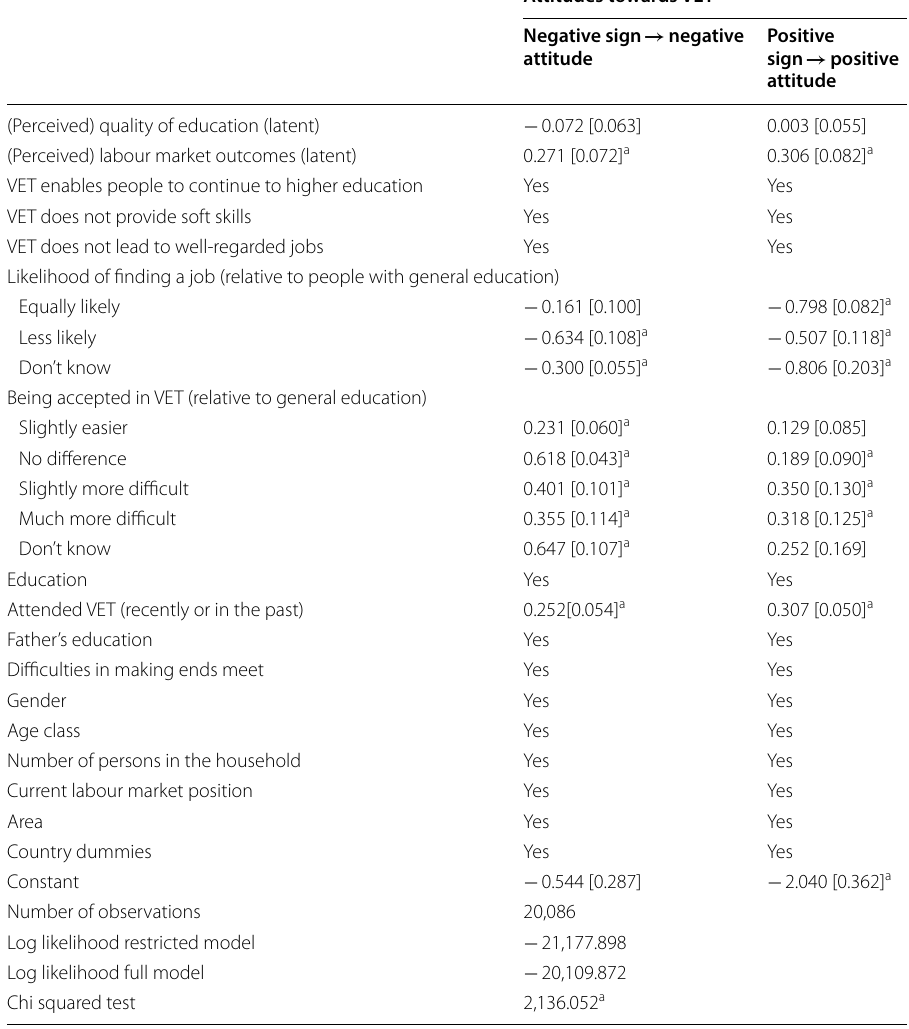
Table 2 Positive and negative attitudes towards